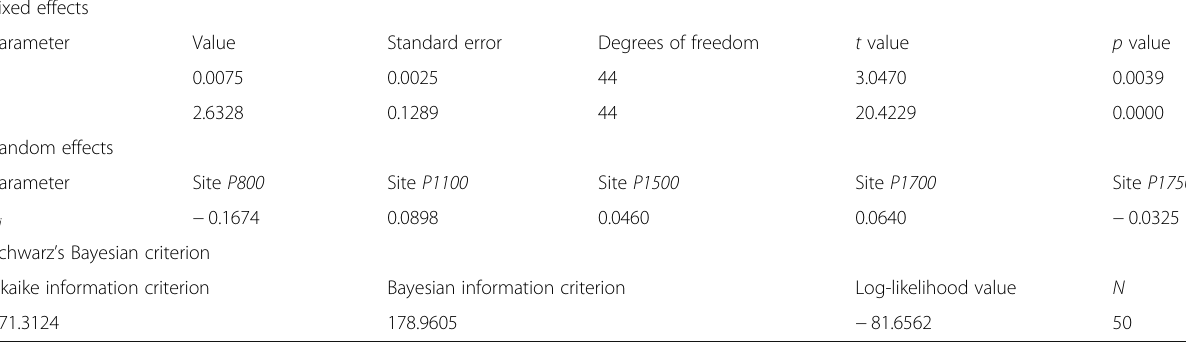
Table 2 Parameters of the nonlinear model of mixed effects adjusted for maximum likelihood to predict leaf biomass of radiata